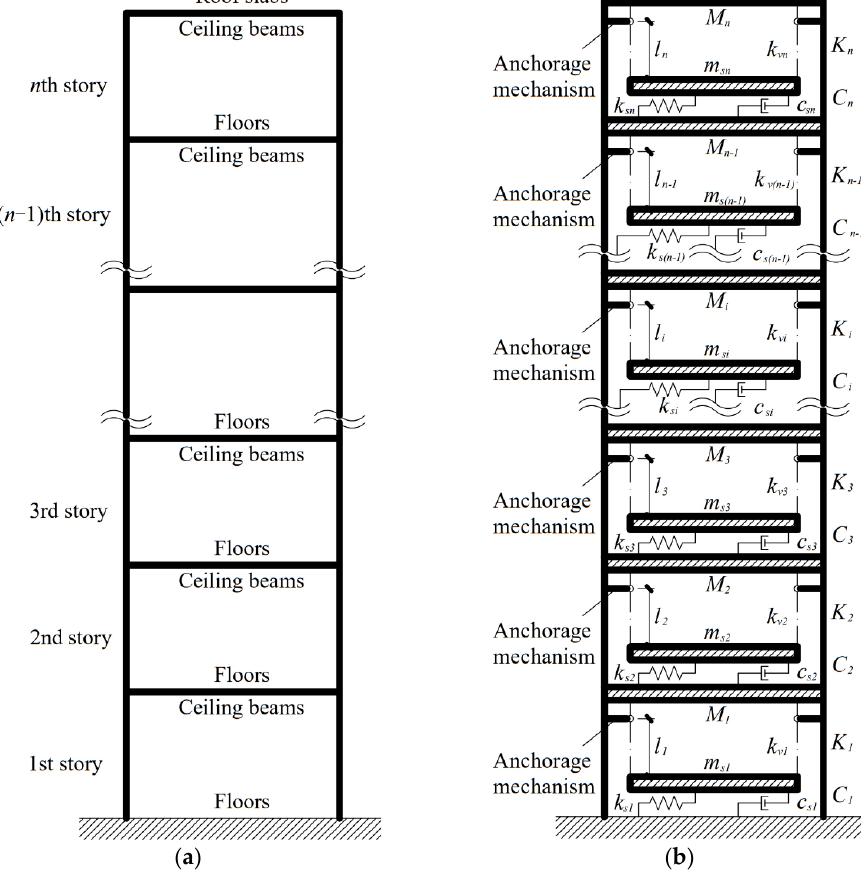
Figure 2. ( a ) Modules after vertical assembly and ( b ) Suspended floor modular system. The roof slabs of the modular building are not isolated from the ceiling beams of modules, using the traditional practice, and the springs and dampers on the ground floor are directly connected to the basics. In Figure 2b, M i and m si are the concentrated masses of the main structure and substructure of the i th story, respectively. K i , k si , and k vi are the stiffness of the i th story’s main structure, the sum of the stiffness of the springs connecting the i th story’s suspended floors and main structure and the equivalent stiffness of the horizontal component of the force of the i th story’s sling, respectively . C i and c si are the damping coefficient of the material of the i th story’s main structure and the sum of the damping coefficient of dampers connecting the i th story’s substructure and main struc ‐ ture, respectively. l i is the length of the i th story’s sling.